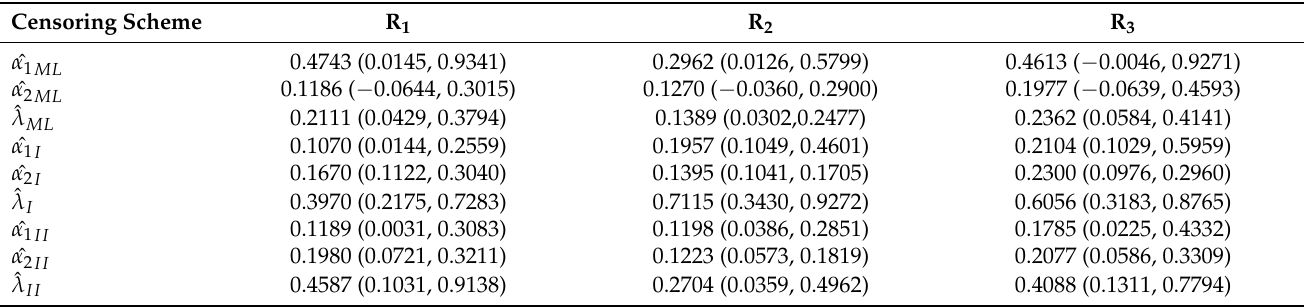
Table 11. The Bayesian estimates and MLEs of the parameters under order restriction and without order restriction with the real